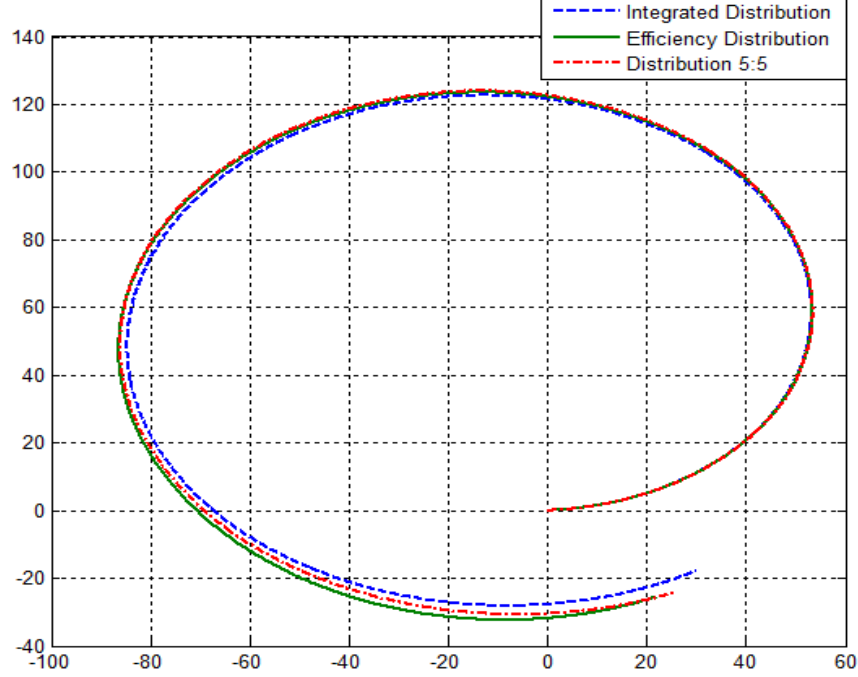
Figure 15. Trajectory of the simulation during circular